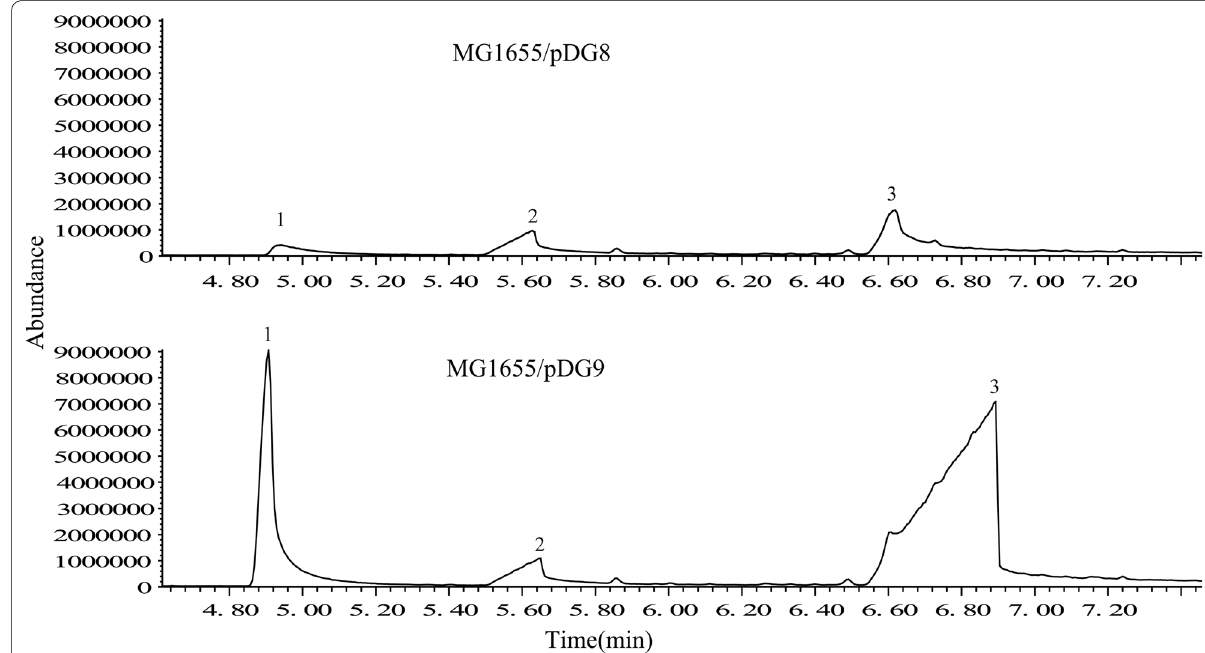
Fig. 2 The GC/MS result of PAA from the extract of the recombinant strain MG1655/pDG8 and MG1655/pDG9 in shake flasks for 28 h. Identified substances: 1 phenethyl alcohol; 2 benzoic acid (used as internal standard, 40 mg/L); 3 phenylacetic acid (PAA)